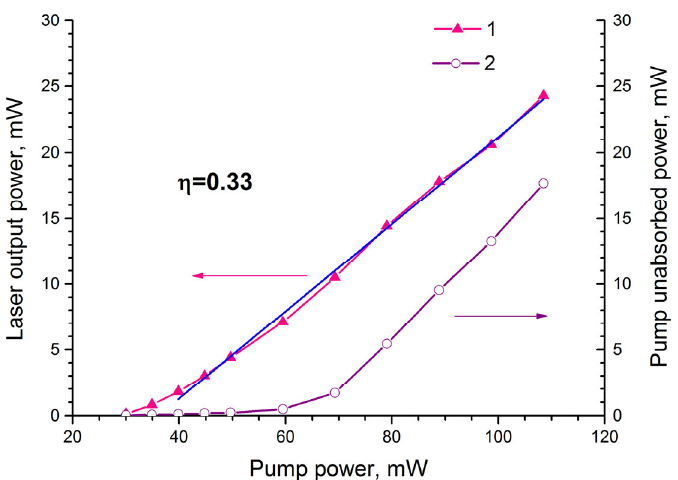
Figure 3. Dependences of the output power (1) and the unabsorbed pump power (2) on the pump power introduced into the resonator of the“random” laser with a resonator length of 8 m.